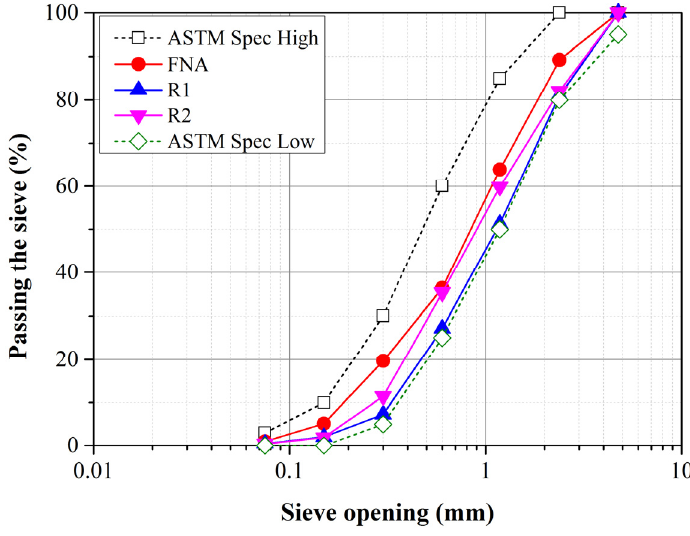
Figure 1. Particle size distribution curves of FNA, R1 and R2 (ASTM C33-13